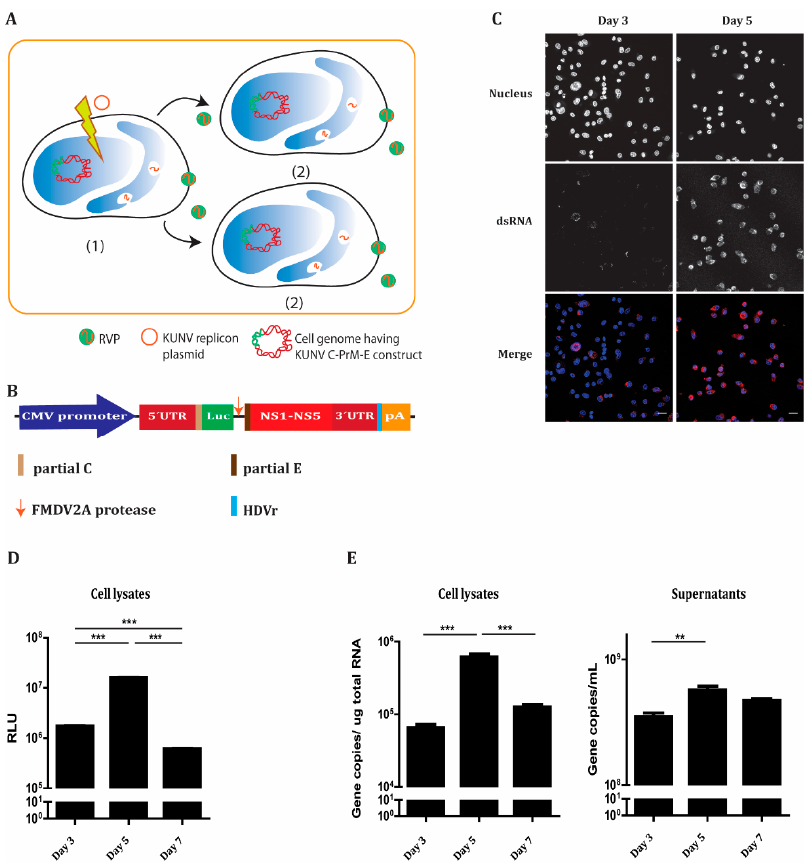
Figure 2. Construction of an enhanced KUNV reporter virus-like particle (RVP) production system. ( A ) The scheme illustrates the infectious cycles to form RVPs. (1) The DNA KUNV replicon is transfected into the stable cell line expressing C-prM-E. The RNA replicon is then expressed and replicated inside replication compartments. The RNA replicon is packaged by C, prM, and E, forming RVPs (2). The RVP progeny may infect and replicate in neighboring C-prM-E expressing cells, forming additional RVPs. ( B ) Schematic illustration of the DNA-based KUNV replicon construct. The replicon is driven by the Cytomegalovirus (CMV) promoter expressing an open reading frame flanked by the 5 (cid:48) - untranslated region (UTR) and the 3 (cid:48) -UTR comprising: first, 81 nucleotides of the C gene fused in frame with the firefly luciferase gene (Luc) as a reporter gene, the foot-and-mouth disease virus autoprotease 2a (FMDV 2A) and, last, 84 nucleotides of the E gene and all the nonstructural proteins. The antigenomic hepatitis delta virus ribozyme (HDVr) sequence was inserted immediately downstream of the KUNV 3 (cid:48) -UTR, followed by the Simian virus 40 (SV40) polyadenylation signal (pA). ( C ) Immunofluorescence labeling of the C-prM-E stable cells transfected with the replicon construct 3 days and 5 days post-transfection with an antibody against dsRNA (red). The nucleus was counterstained by DAPI (blue). Bar scales represent 20 µ m. ( D ) Relative luciferase units (RLU) from cell lysates 3–7 days post-transfection. ( E ) Gene copy numbers of replicon from cell lysates, and cell culture supernatants 3–7 days post-transfection as measured by qPCR. The experiments were conducted independently three times with two technical repeats. The p values are indicated using ** p < 0.01 and *** p <